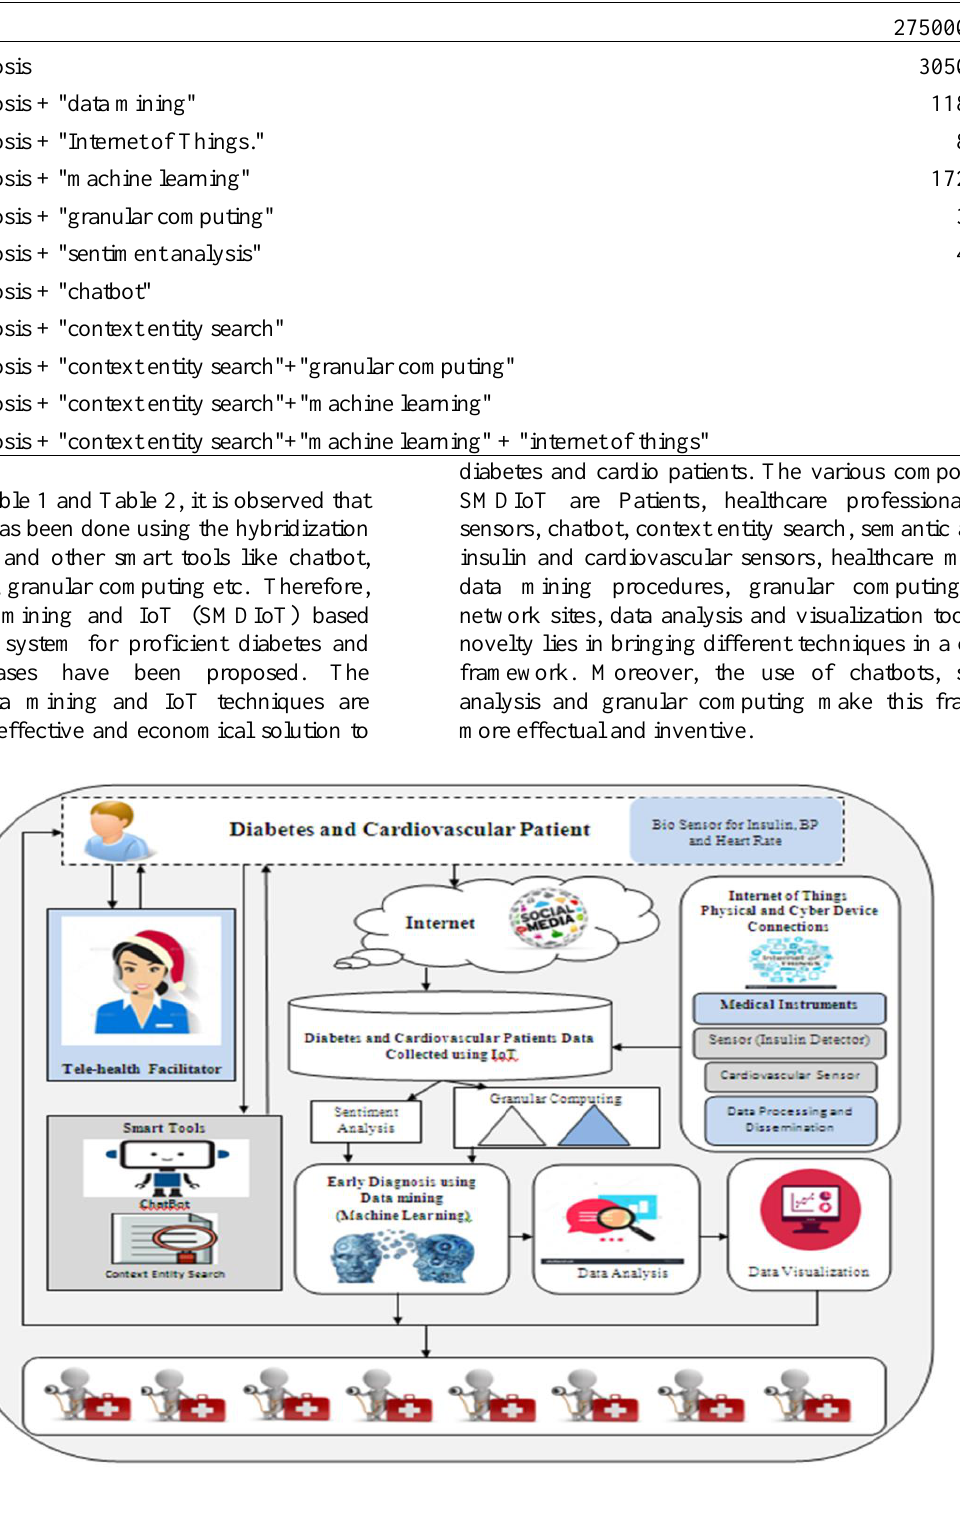
Figure 3: Data Mining and IoT based Smart and Advanced Healthcare System